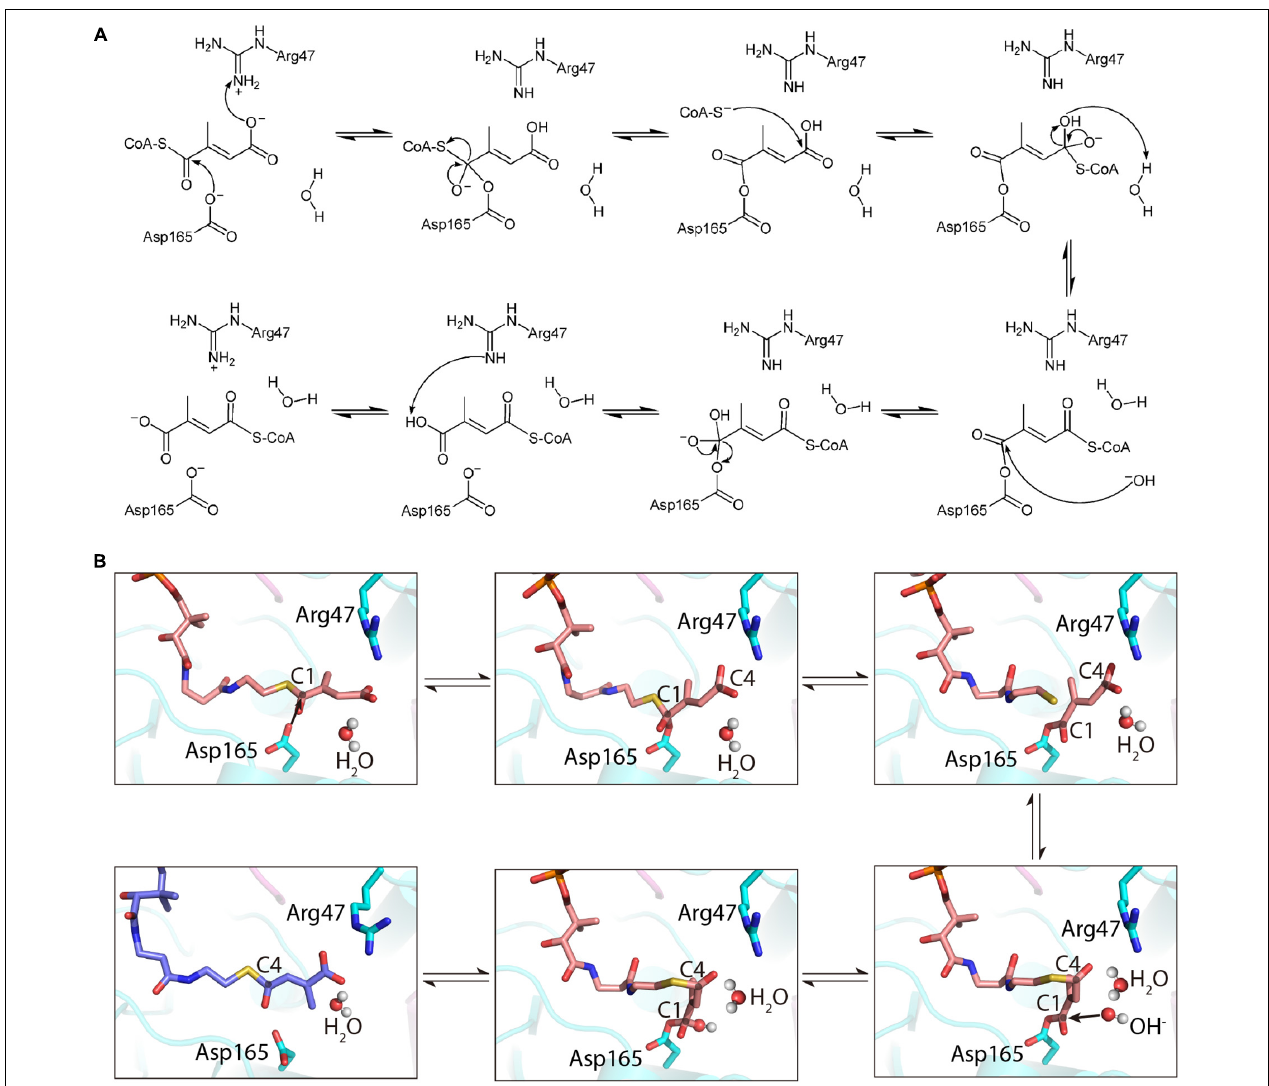
FIGURE 6 | Illustration of the proposed mechanism of R. castenholzii MCT as an intramolecular CoA-transferase. (A) The proposed mechanism of MCT in catalyzing the reversible CoA transfer between mesaconyl-C1-CoA and mesaconyl-C4-CoA. (B) Cartoon presentation of the mechanism of MCT in catalyzing the intramolecular CoA transfer reaction. Mesaconyl-C1-CoA (salmon), mesaconyl-C4-CoA (blue), and the key amino acid residues Arg47 and Asp165 are shown in stick models, and the water molecules are shown as